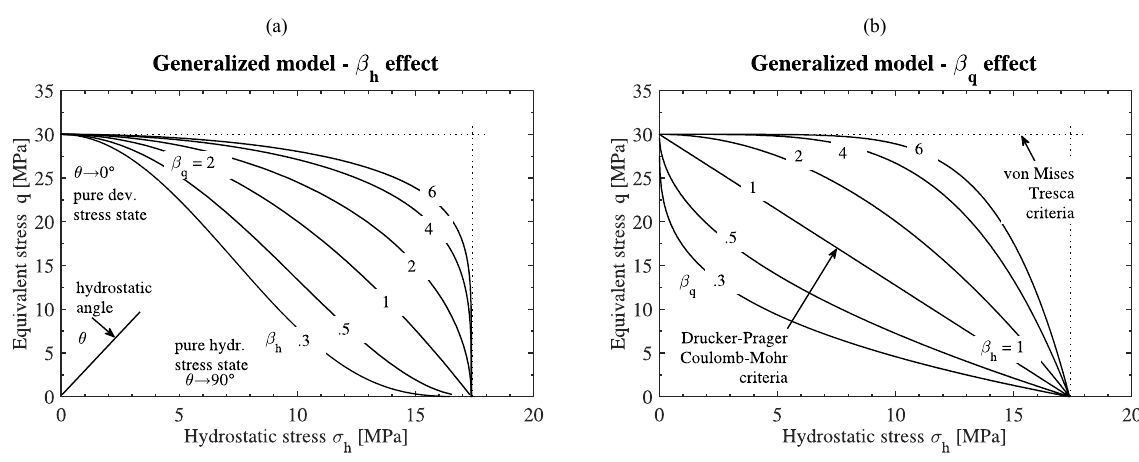
Fig. 4 Effects of  h (a) and  q (b) parameters on the meridian curve of the proposed model The shape of the curve is directly affected by the values of these two parameters  and  . More specifically, (i)  q h h rotates clockwise up to affects the tangent of the curve at deviatoric stress equal to zero, which at increasing  h affects the tangent of the curve at hydrostatic stress vertical position (indicated by vertical dotted line) and (ii)  q rotates counter clockwise up to horizontal position (indicated by horizontal equal to zero, which at increasing  q dotted line). It is also observed that existing models are particular cases of the proposed model (indicated with arrows in Fig. 4 (b)), as discussed more in detail in the following section.